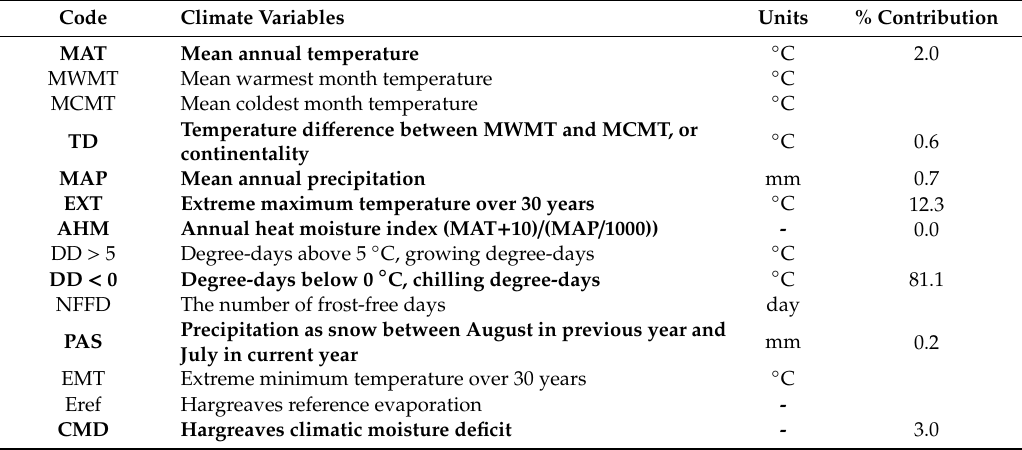
Table 1. Climate variables provided by Climate AP and their percentage contribution. The variables with bold fonts were used in the